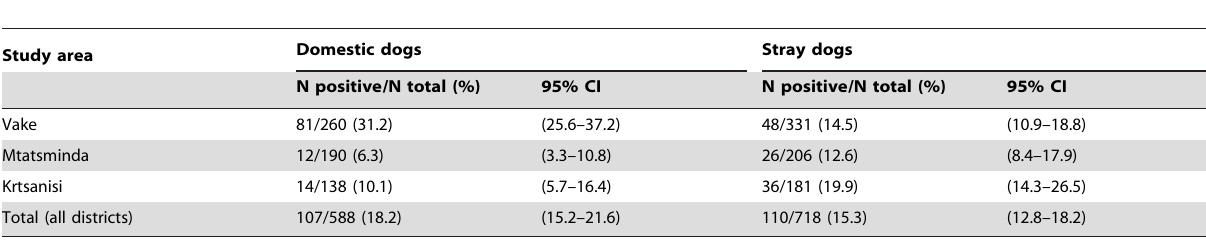
Table 3. Prevalence of Leishmania seropositivity in domestic and stray dogs from the study